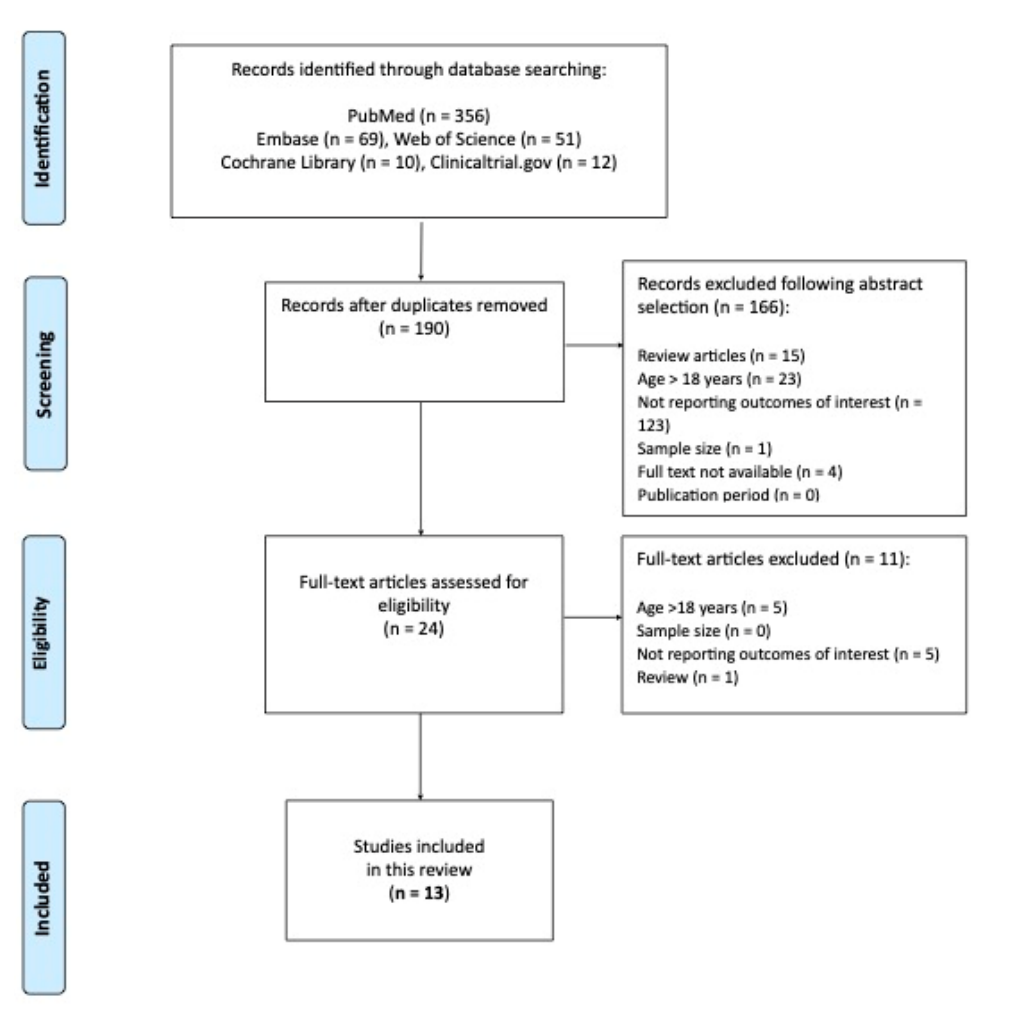
Figure 1. The PRISMA flow diagram.